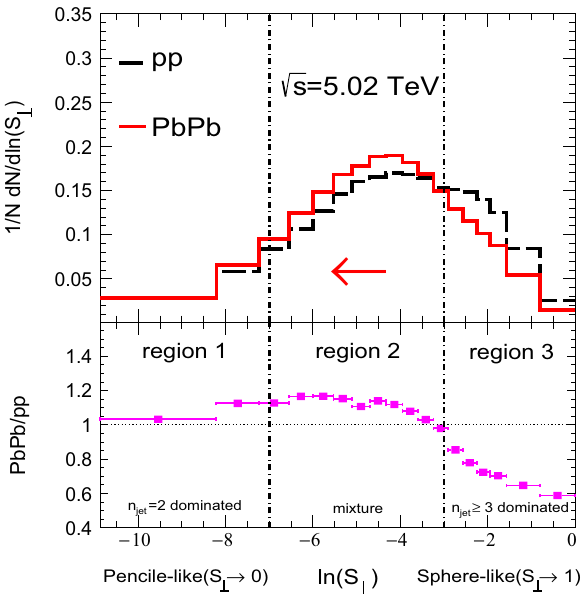
Fig. 3 Top: event normalized transverse sphericity distribution of the total events in p+p and Pb+Pb collisions at medium modification factor of event normalized S ⊥ distribution of the total events